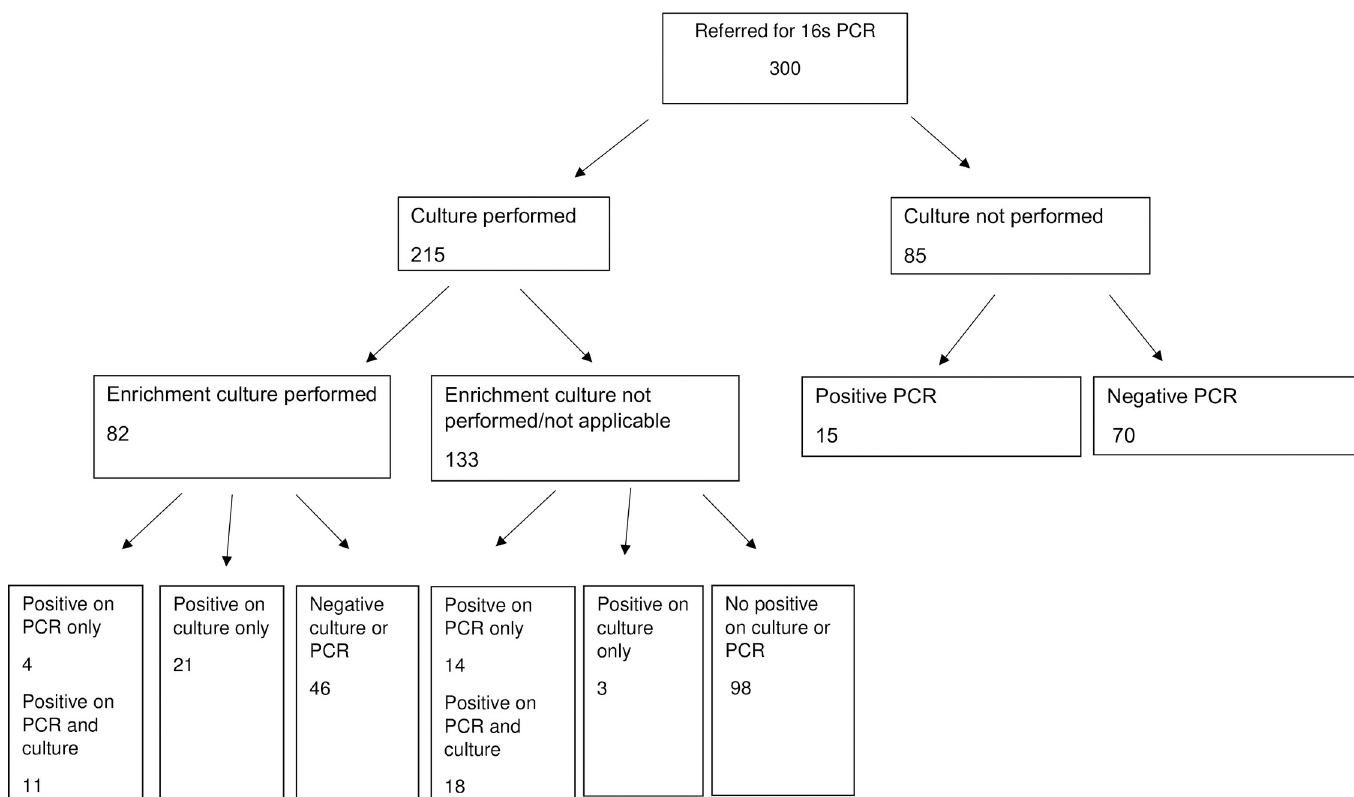
Fig 1. Results for samples referred for 16s PCR versus conventional culture and enrichment culture.